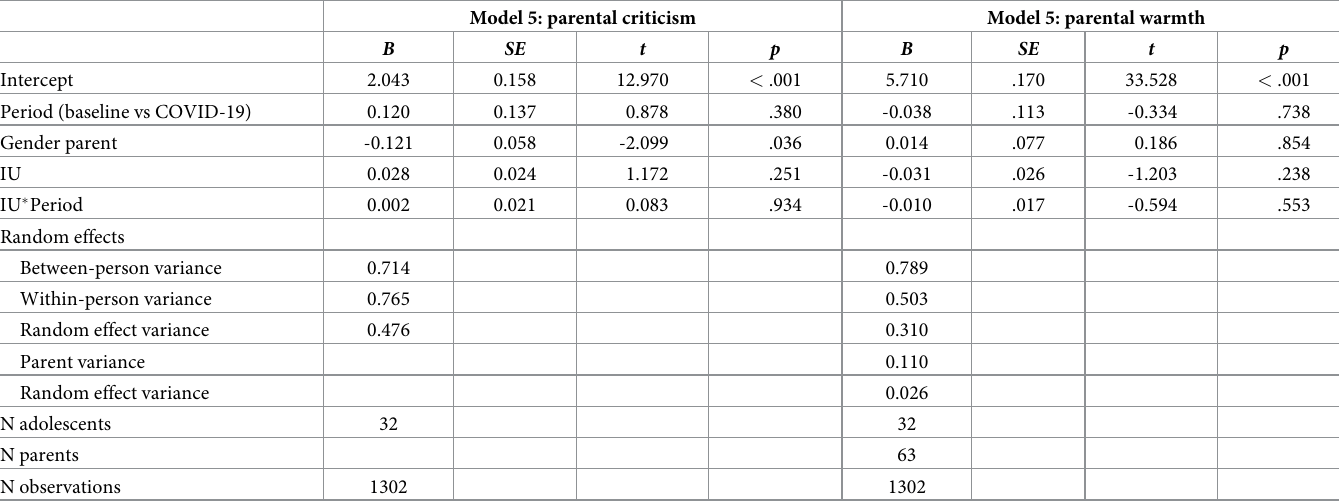
Table 5. Results of final model 5 on the relation between period and daily parenting behavior and the moderating role of intolerance of uncertainty in